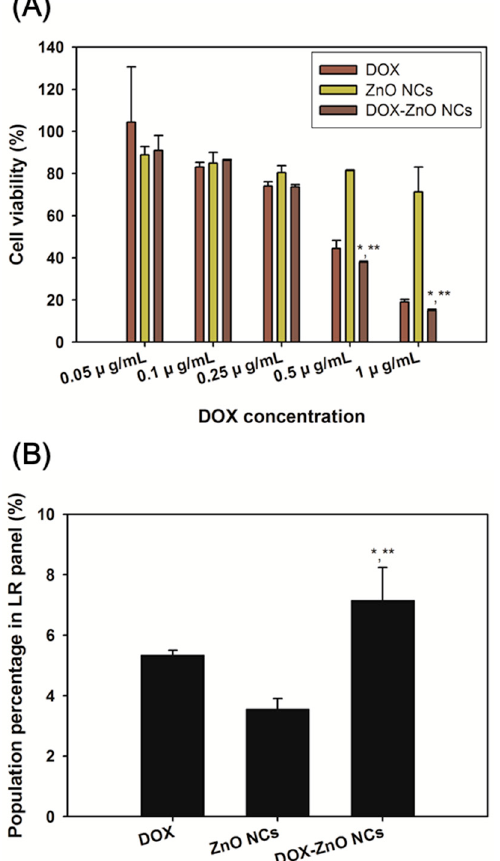
Figure 7. Anticancer activities of DOX-ZnO NCs in Caco-2 cells. ( A ) Antiproliferation efficacy of DOX-ZnO NCs in Caco-2 cells. Cell viability values of DOX, ZnO NCs, and DOX-ZnO NCs groups in Caco-2 cells are shown. Each point indicates the mean ± SD ( n = 3). * p < 0.05, compared with DOX group. ** p < 0.05, compared with ZnO NCs group; ( B ) Reactive oxygen species (ROS) levels after treatment of DOX, ZnO NCs, and DOX-ZnO NCs in Caco-2 cells. The population percentages in the lower right (LR) panel of DOX, ZnO NCs, and DOX-ZnO NCs groups are shown. Each point indicates the mean ± SD ( n = 3). * p < 0.05, compared with DOX group. ** p < 0.05, compared with ZnO NCs group.